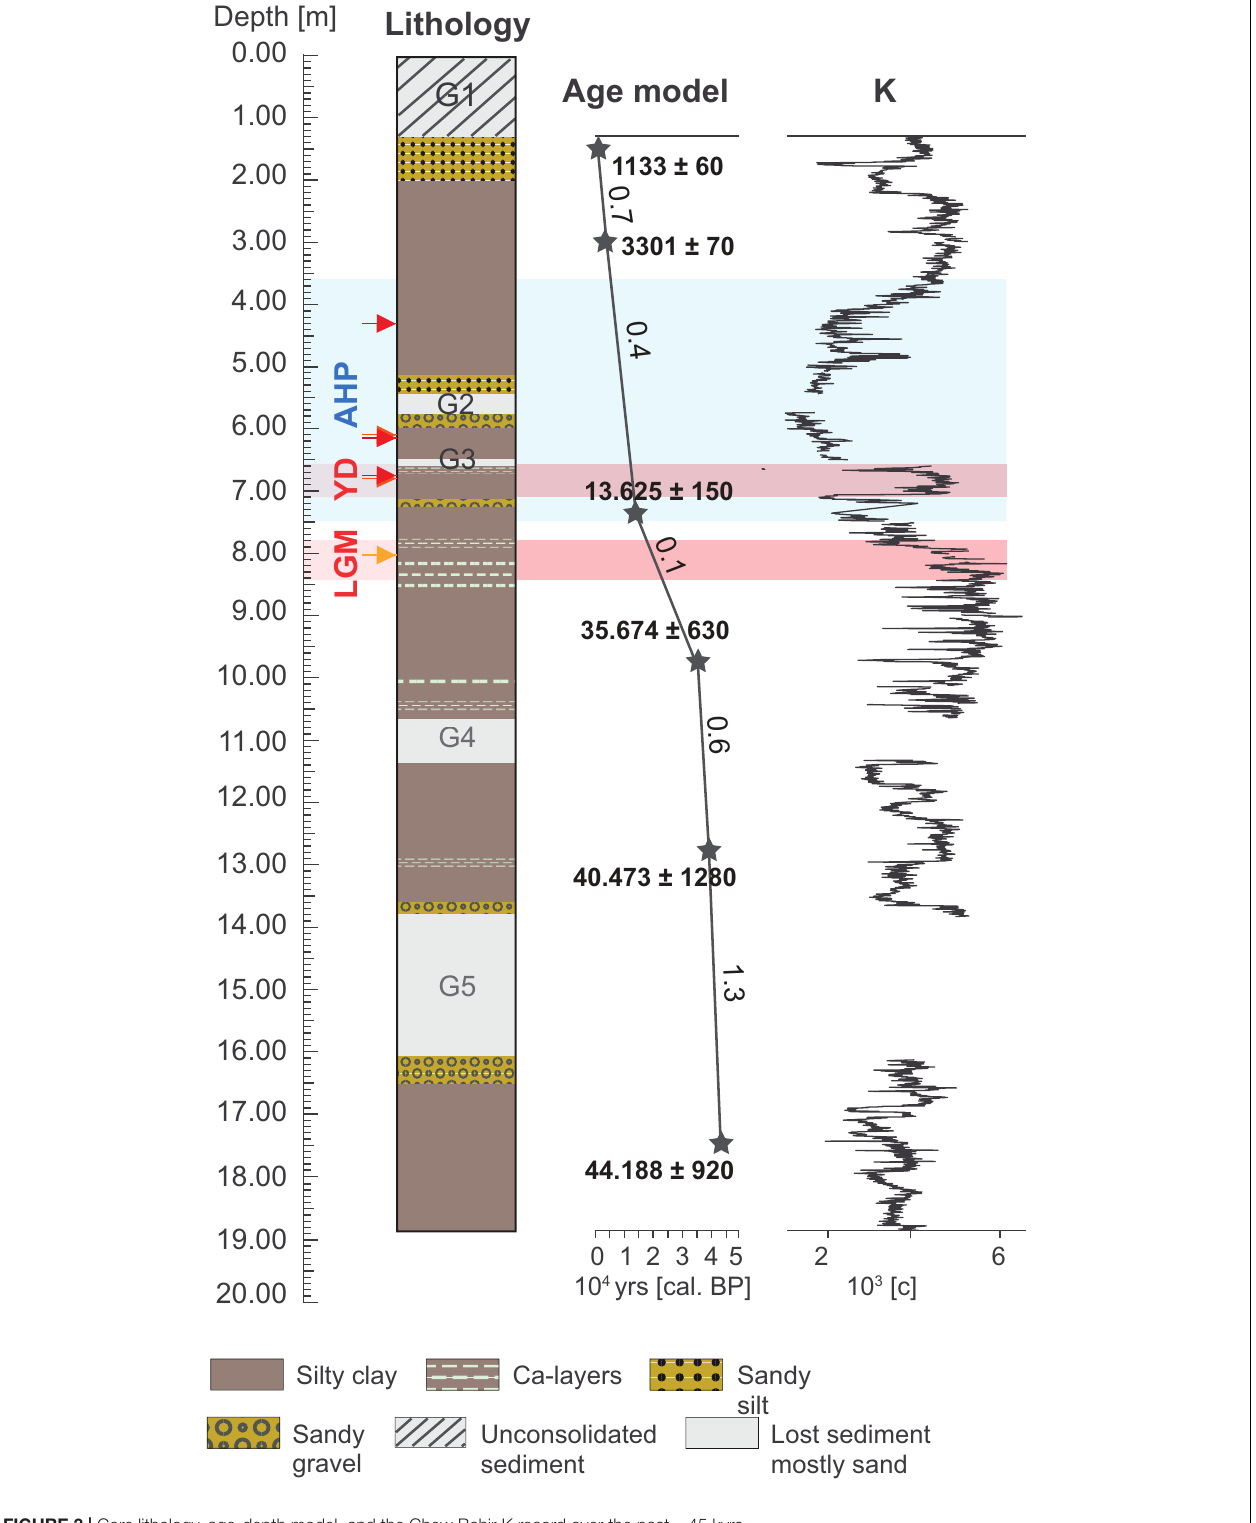
Frontiers in Earth Science |